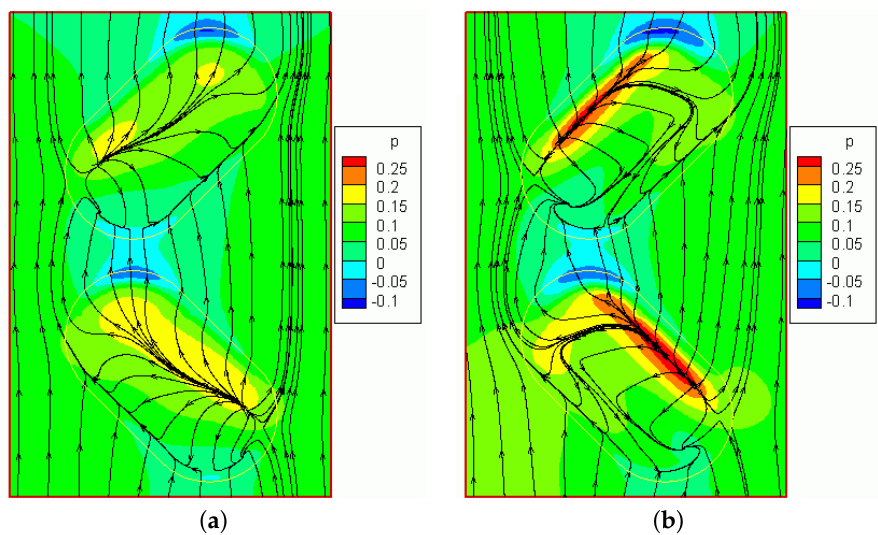
Figure 10. Comparison of patterns of coolant spreading over the wall with oval dimples 0.1 ( a ) and 0.2 ( b ) deep with applied pressure fields.